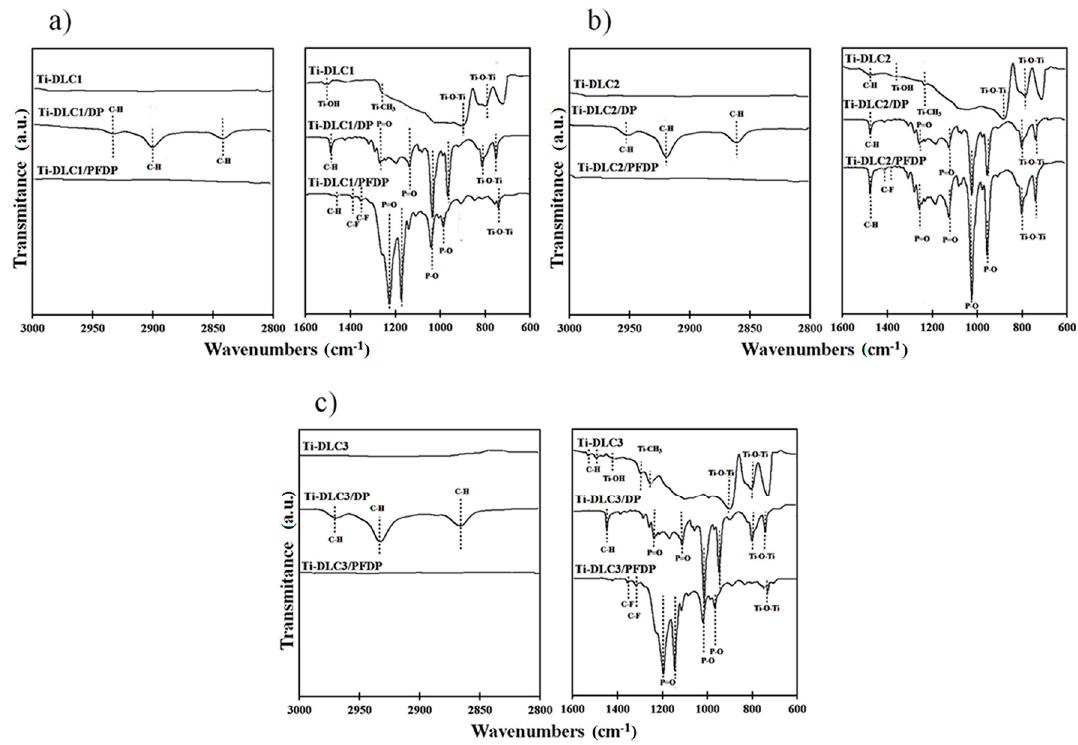
Figure1. FTIRspectraof( a )Ti-DLC1, ( b )Ti-DLC2and( c )Ti-DLC3coatingsbeforeandaftermodification Figure 1. FTIR spectra of ( a ) Ti-DLC1, ( b ) Ti-DLC2 and ( c ) Ti-DLC3 coatings before and after by DP and modification by DP and PFDP.